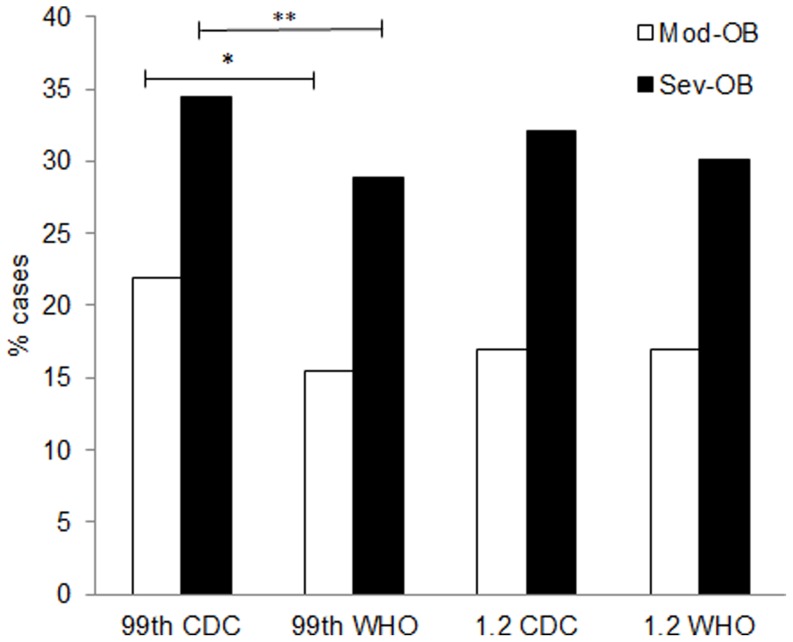
Relative frequency of clustered cardiometabolic risk factors in children with moderate (Mod-OB) or severe obesity (Sev-OB) defined according to BMI-for-age ≥99th percentile or ≥1.2 times the 95th percentile, by CDC or WHO.